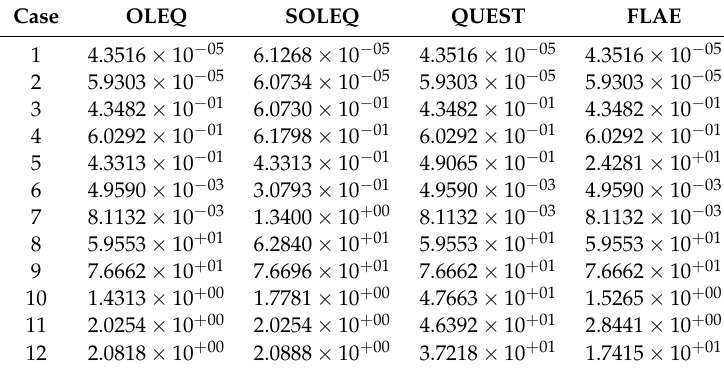
Table 2. Roll RMSE (deg). SOLEQ, Suboptimal Linear Estimator of Quaternion; QUEST, Shuster’s QUaternionESTimator; FLAE, Fast Linear Attitude